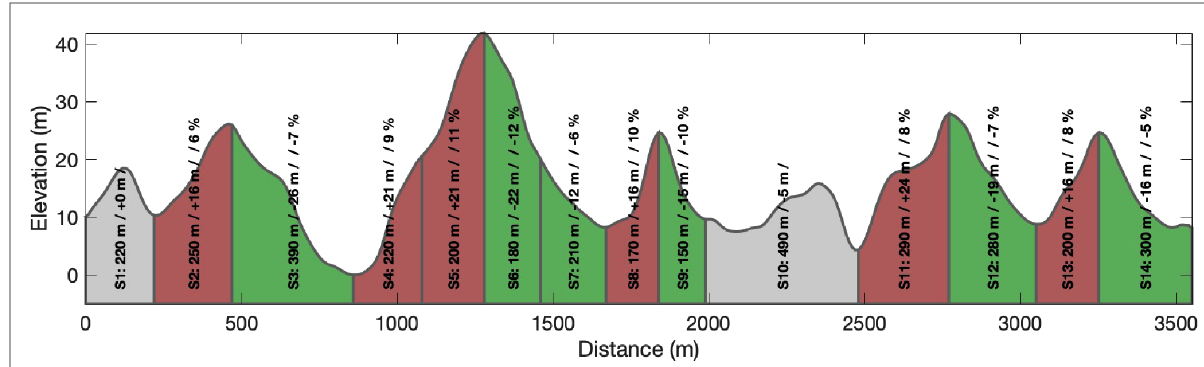
FIGURE 1 Two-dimensional pro fi le of the racecourse used on Laps 2 – 6 in a 21.8 km cross-country skiing mass-start competition, showing elevation [m] as a function of lap-distance divided into different terrain segments (S1 – S14) with segment distance [m], climb [m], and inclination [%] visualised. Lap 1 was shorter than the other laps but consisted of all segments except S5 and S6. The uphill segments are displayed in red, fl at segments in grey, and downhill segments in green.